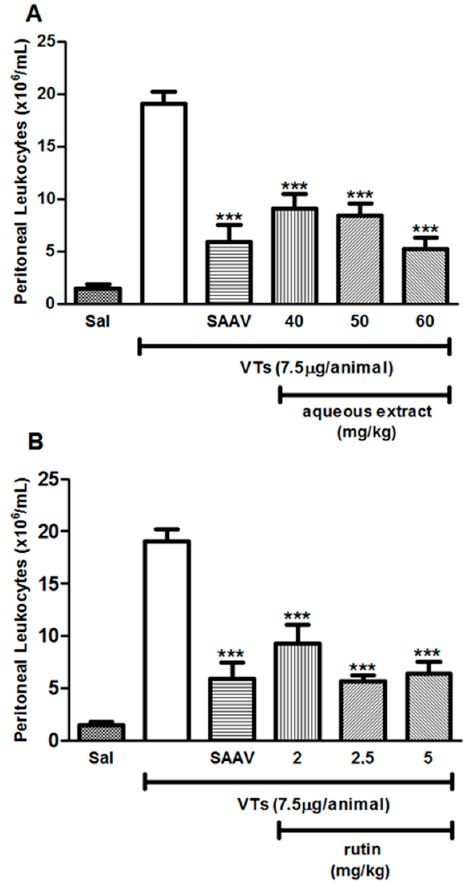
Figure 5. Anti-inflammatory effect of aqueous extract from the leaves of Aspidosperma pyrifolium and rutin on VTs-induced peritonitis model. The animals received an intraperitoneal injection of 100 µ L of VTs and were treated at the same time with: AE (40, 50 and 60 mg/kg, intravenous) ( A ); or rutin (2, 2.5 and 5 mg/kg, i.v.) ( B ). Saline or arachnidic antivenom (SAAV, 50 µ L/animal, intravenous) was used as negative or positive control, respectively. The peritoneal cell infiltration was analyzed after 6 h. *** p < 0.001 when compared to the venom group. Data were analyzed using ANOVA followed by Tukey Test. Sal: saline; SAAV: arachnidic antivenom and VTs: Tityus serrulatus venom. Table 2. Anti-inflammatory activity of aqueous extract (AE) from the leaves of Aspidosperma pyrifolium and rutin against Tityus serrulatus venom-induced peritonitis model.